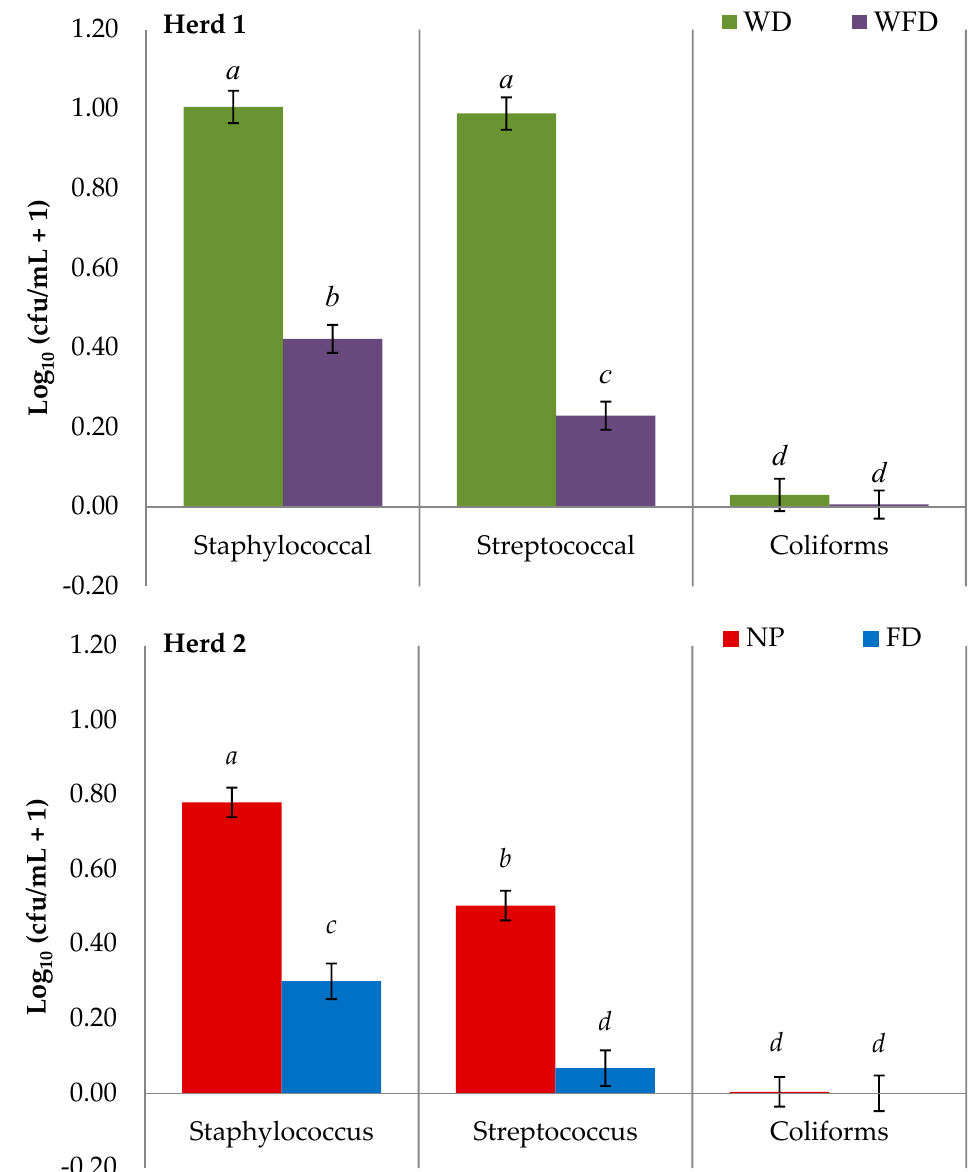
Figure 3. LS-means of the Log 10 bacterial counts of staphylococcal, streptococcal, and coliform isolates on teat swabs taken after four different pre-milking teat preparation regimes across two dairy herds. (WD = wash with water and dry wipe, WFD = wash with water, foam application and dry wipe, NP = no teat preparation, FD = foam application and dry wipe). ( a–d ) Means with different letters within herd differ significantly. Error bars indicate SEM.